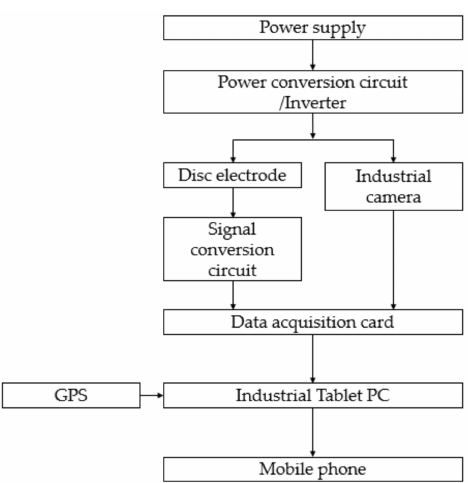
Figure 7. Schematic diagram of